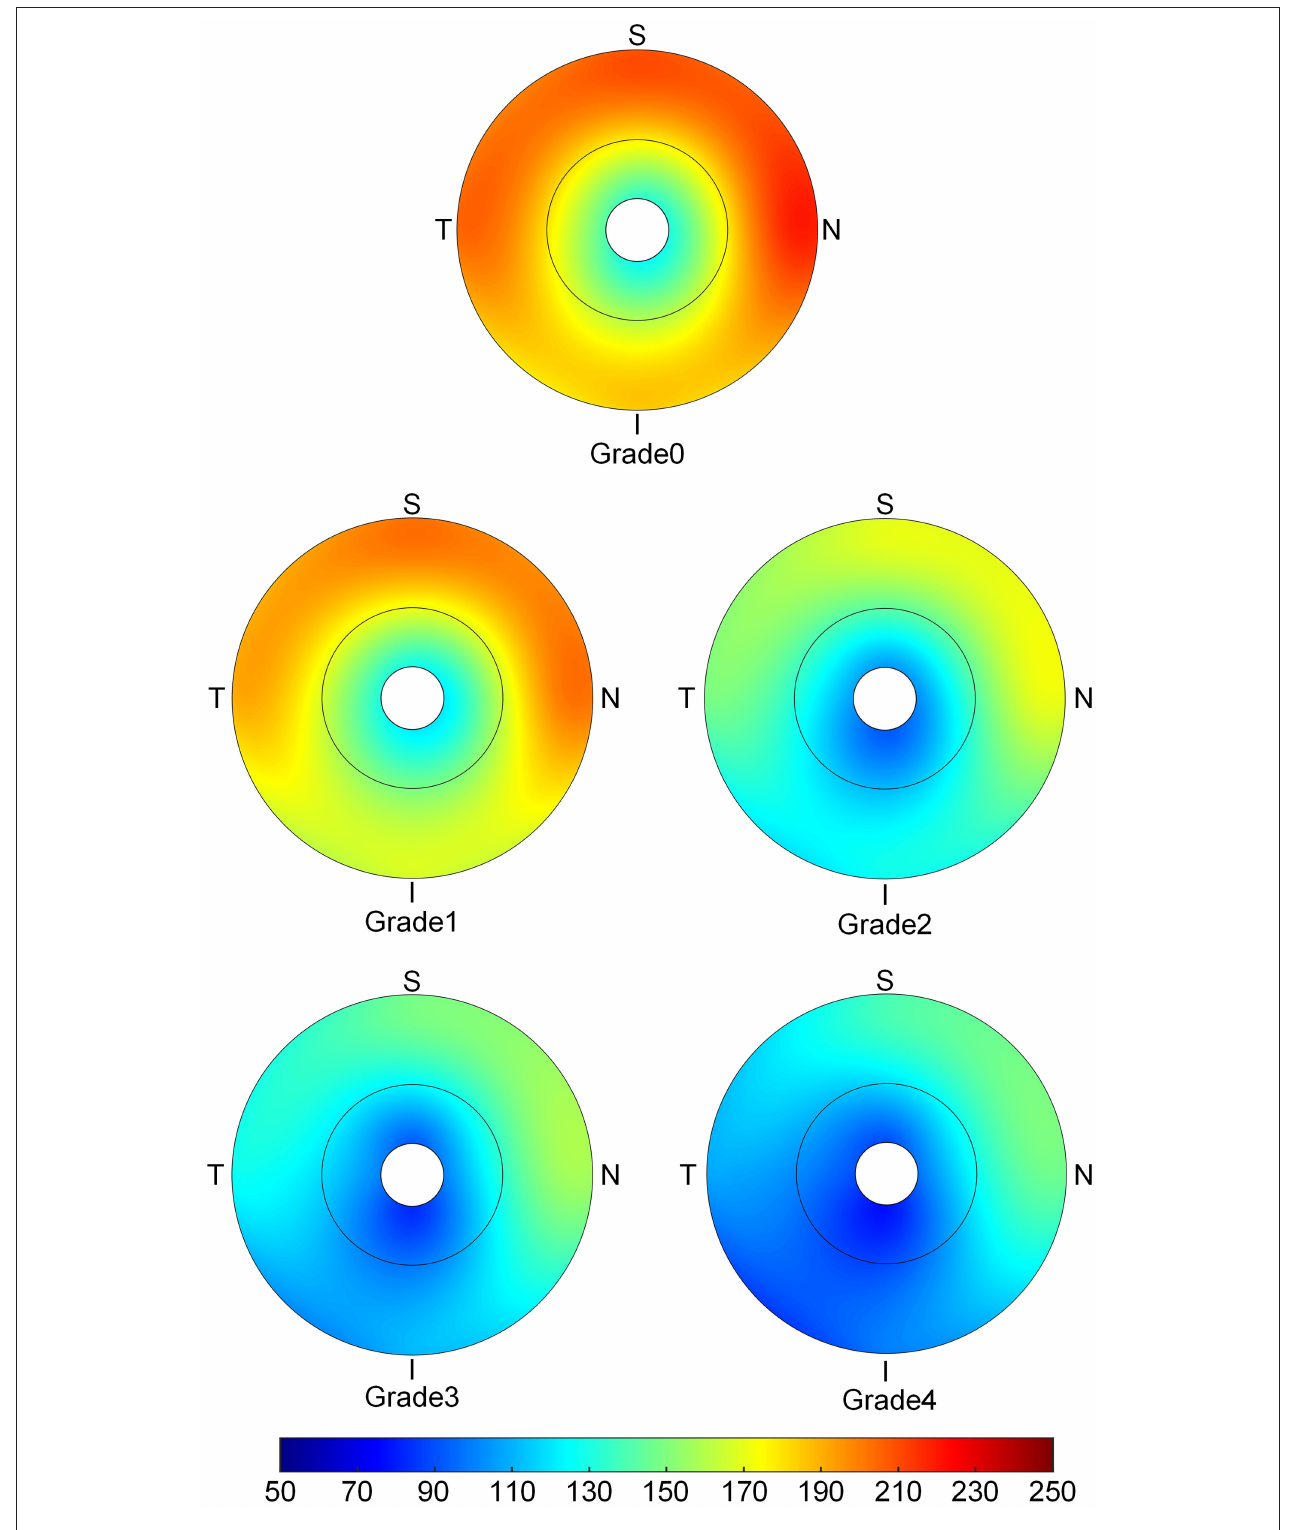
FIGURE 4 | The topographic characteristics of choroidal layer thickness in ETDRS grid centered in optic disc range from Grade 0 to Grade 4. The value of choroidal thickness was shown in different color, with color red as the thickest to color blue the thinnest.